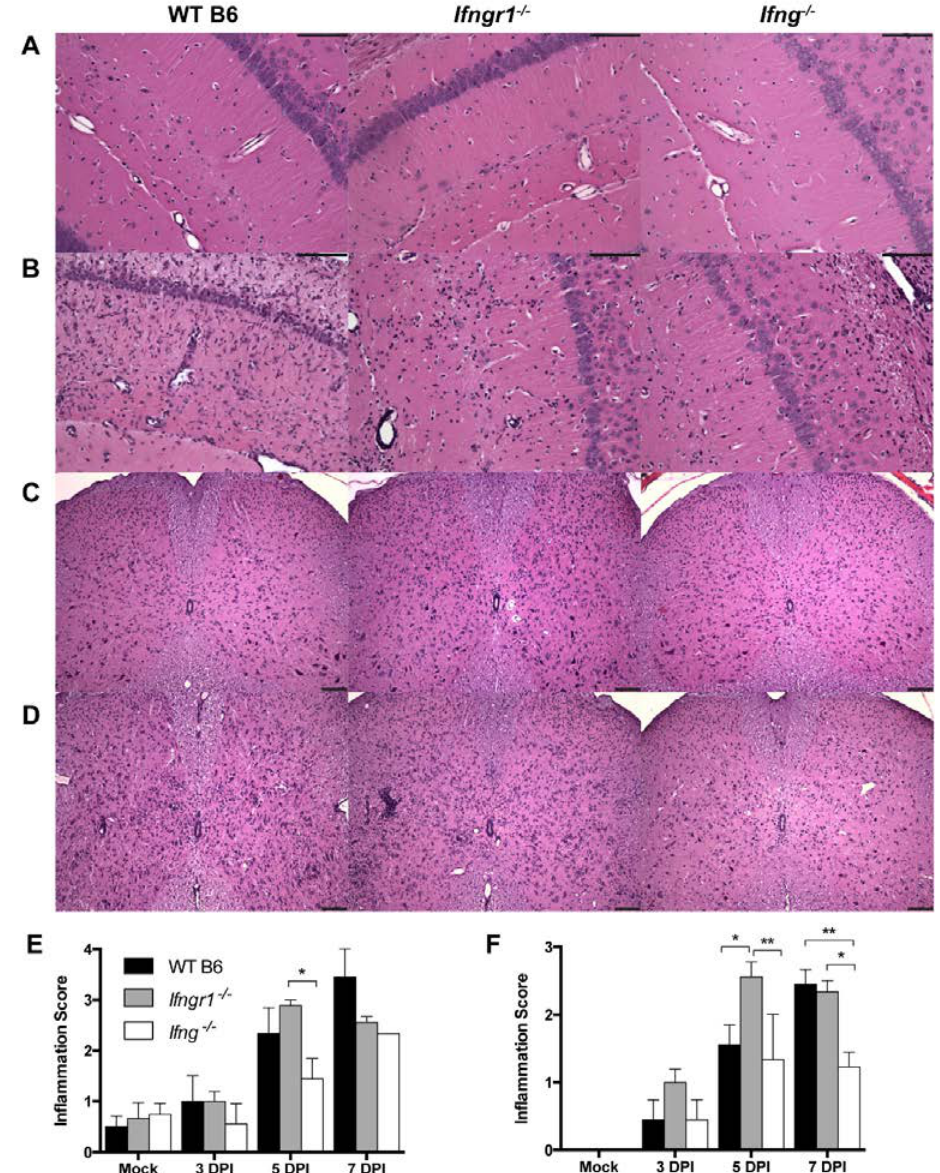
Figure 6. Inflammation in the brain and spinal cord of SINV-infected WT, Ifngr1 − / − , and Ifng − / − mice. ( A – D ) Representative photomicrographs were taken of H&E-stained brain ( A , B ) and spinal cord ( C , D ) sections from mock-infected mice ( A , C ) and SINV-infected mice at 7 DPI ( B , D ) (brain = 200 × magnification and spinal cords = 100 × magnification, scale bar = 100 µ m). ( E , F ) H&E sections of brains ( E ) and spinal cords ( F ) of WT (black bars), Ifngr1 − / − (gray bars), and Ifng − / − (white bars) mice either mock-infected or SINV-infected at 3, 5 or 7 DPI were scored for inflammation using a four-point (brain) or three-point (spinal cord) system (data are presented as the mean score ± SEM for 3–4 mice per strain per group; * p < 0.05 and ** p < 0.01, Tukey’s multiple comparisons test).